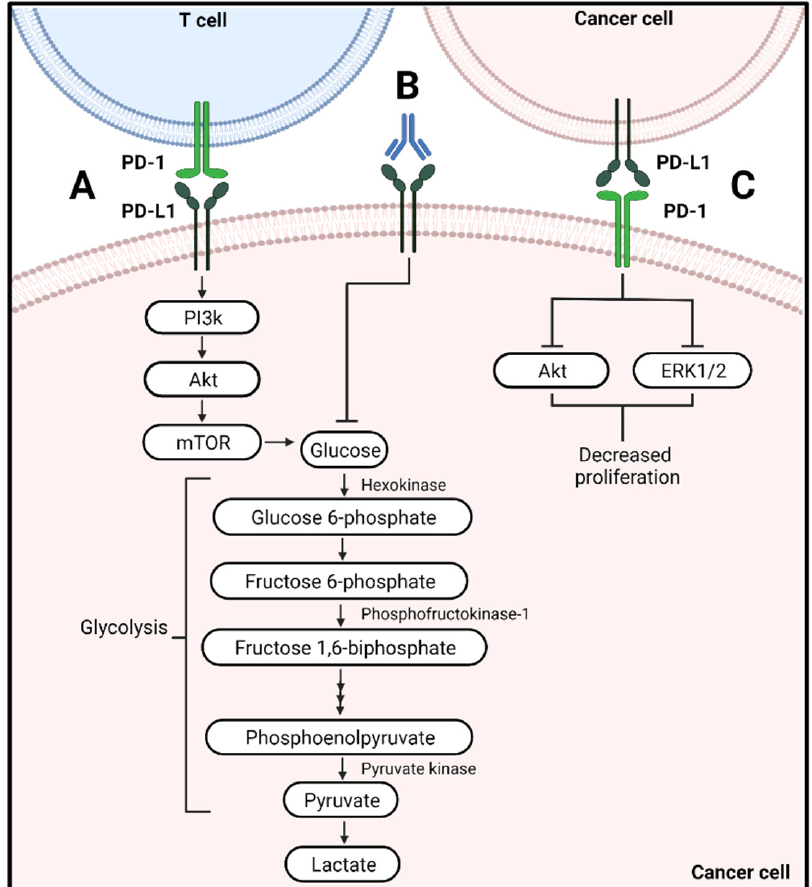
Figure 3. Regulation of metabolic signaling of immune checkpoint inhibitors on cancer cells. ( A ) PD- L1 engagement results in activation of glycolysis and activation of the PI3K/Akt/mTOR pathway. ( B ) Antibodies to PD-L1 are known to inhibit its metabolic signaling. ( C ) PD-1 on cancer cells limits Akt and ERK1/2 signaling regulating cancer cell proliferation.